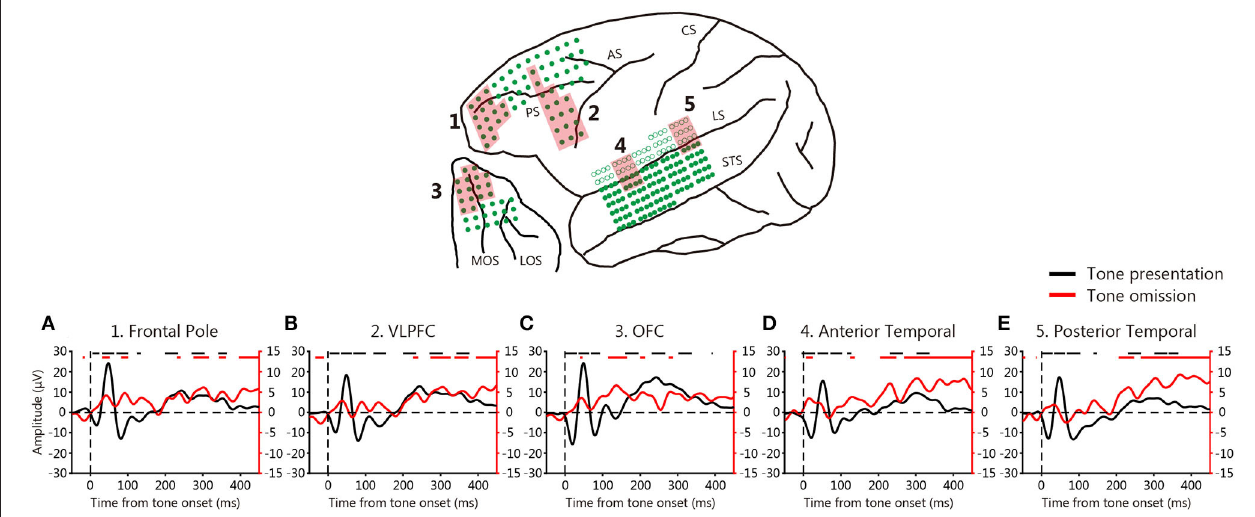
FIGURE 2 | Event-related potentials (ERPs) during the omission paradigm. (A–E) ERPs averaged across 3 monkeys. Each line shows the average ERP across 16 electrodes in each area (red shading) that were averaged across 3 monkeys. Black lines: ERPs at tone presentation; red lines: ERPs at tone omission. The black and red lines on the tops of the graphs indicate deflections that deviated from zero (one-sample t -test, p < 10 − 6 , FDR-corrected).